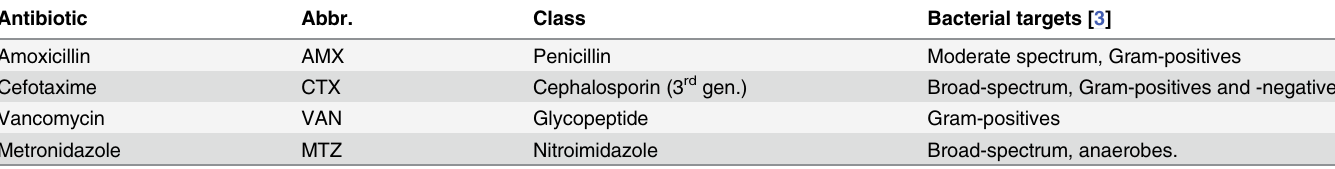
Table 1. Characteristics of antibiotics used in the study.